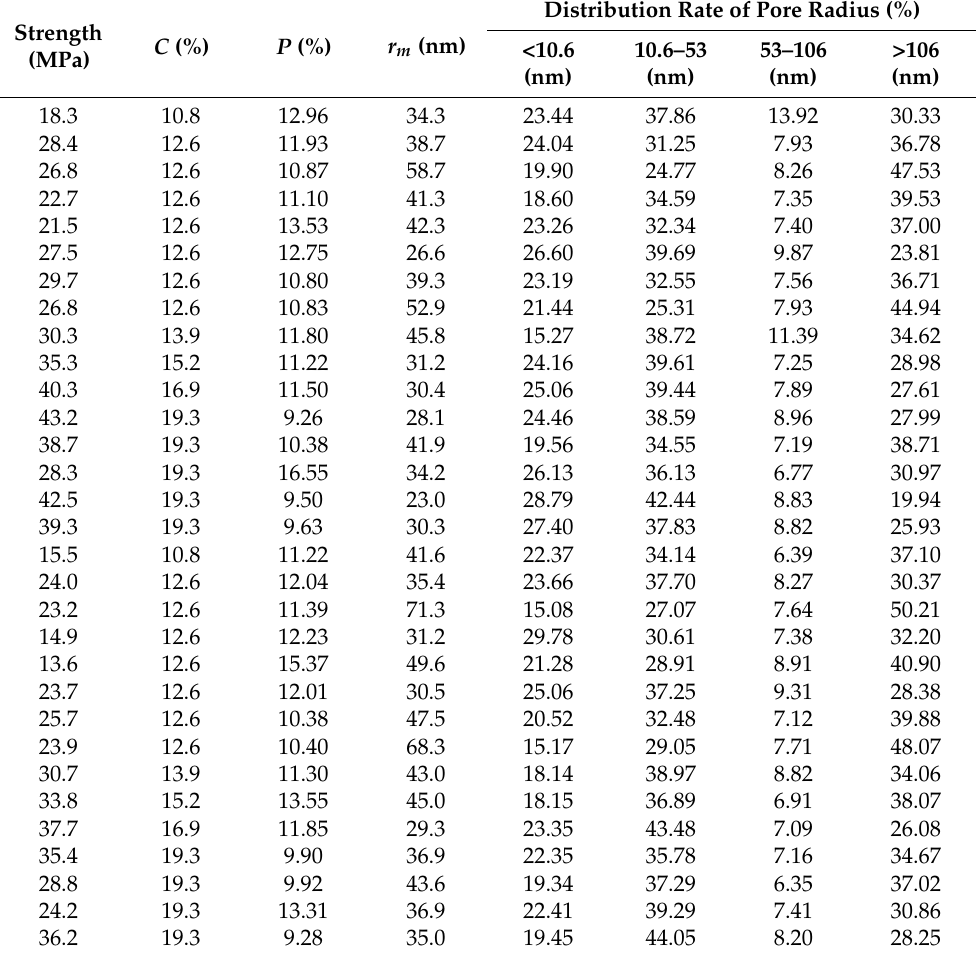
Table 1. Concrete parameters (data